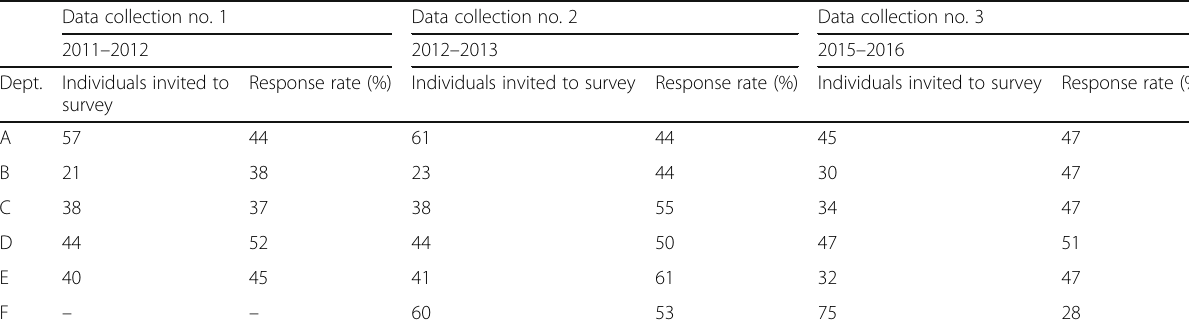
Table 1 Survey response rates by data collection timestamp Data collection no. 1